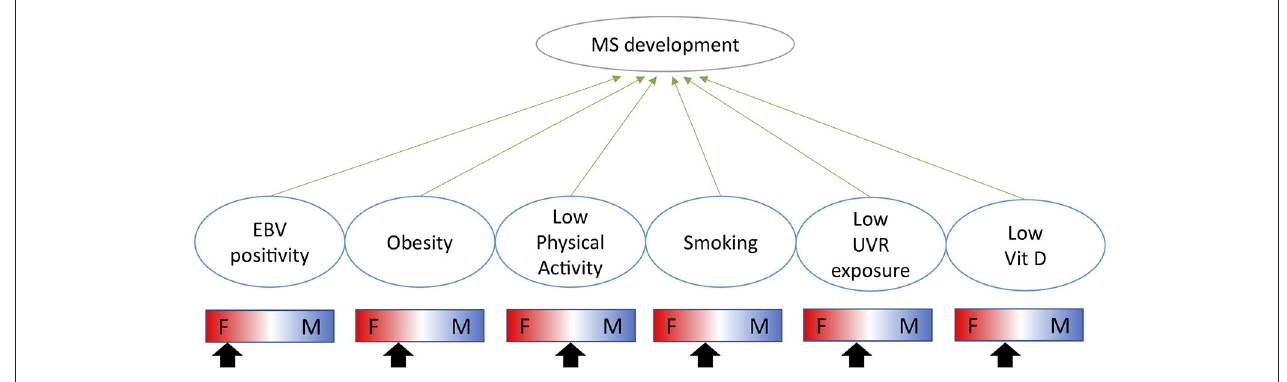
FIGURE 1 | Indication of how each environmental risk factor impacts males and females differently and whether each factor is likely to increase the risk of MS more in females (F) or males (M) as indicated by the